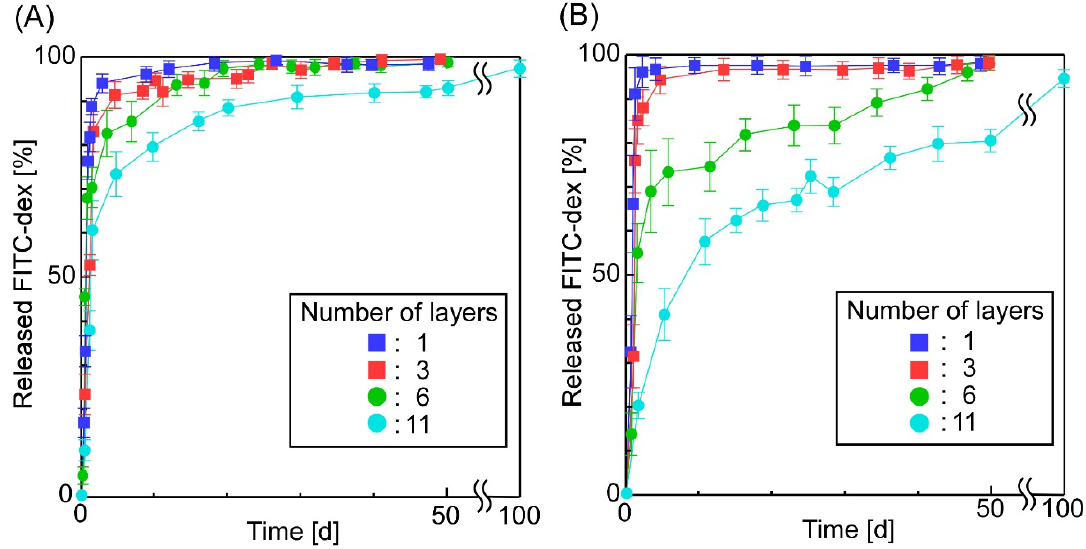
Figure 4. The effect of the number of layers on the release properties of the sheets (the sheet-forming polymers were ( A ) PLA (2 w/v%) and ( B ) PLA (2 w/v%) + PLGA (2 w/v%); number of layers: 11).